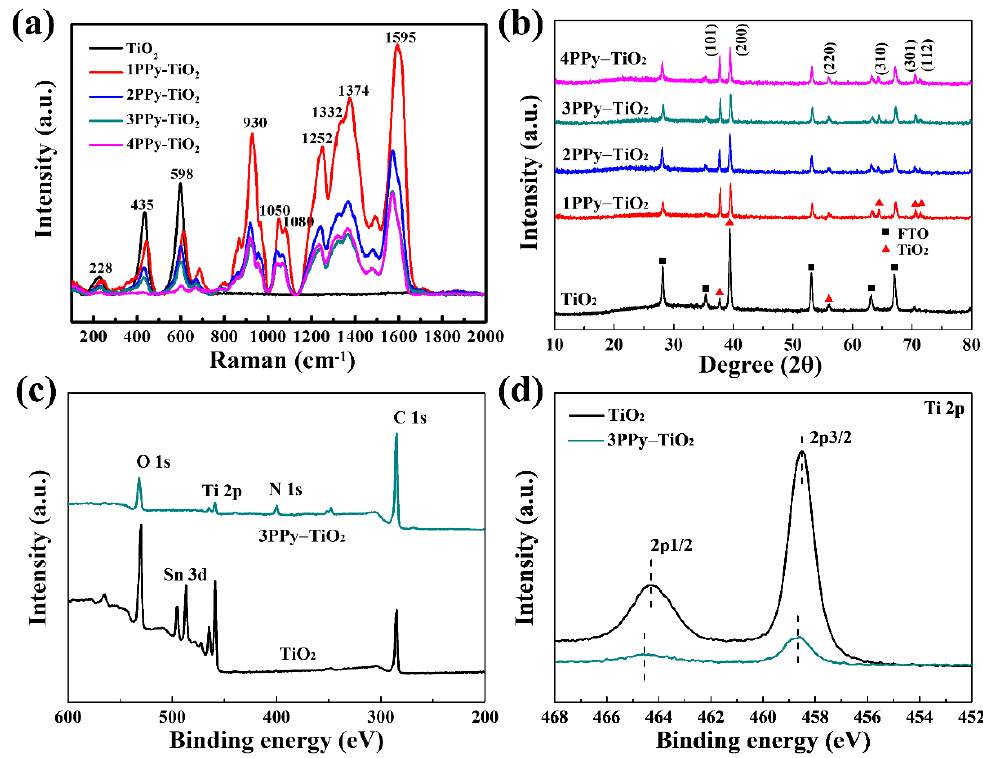
Figure 4. Raman spectra ( a ) and XRD patterns ( b ) of pure TiO 2 and nPPy-TiO 2 nanocomposites prepared by different deposition times; XPS surveys ( c ) and high-resolution Ti2p spectra ( d ) of pure TiO 2 and 3PPy-TiO 2 .